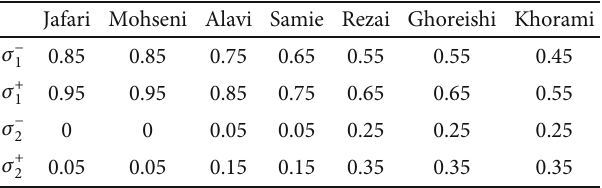
Table 3: Employee power based on degree of membership and